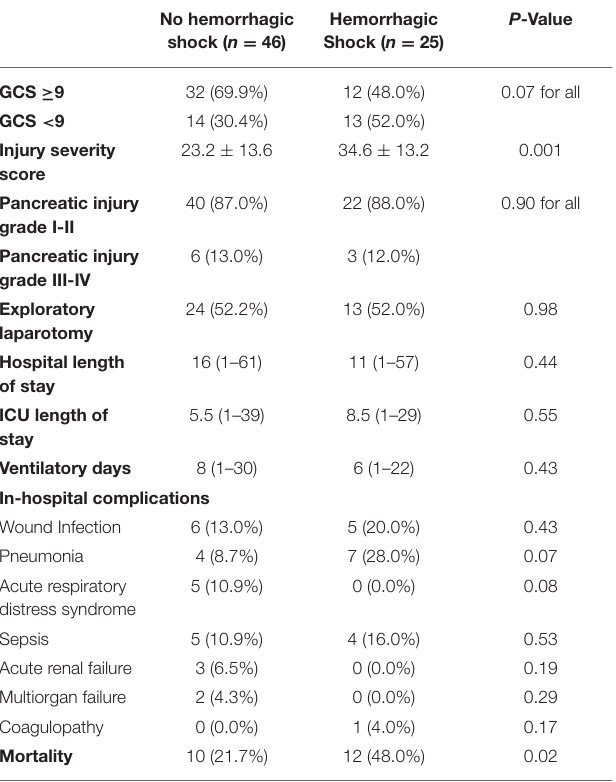
TABLE 4 | Pancreatic injury with and without shock.